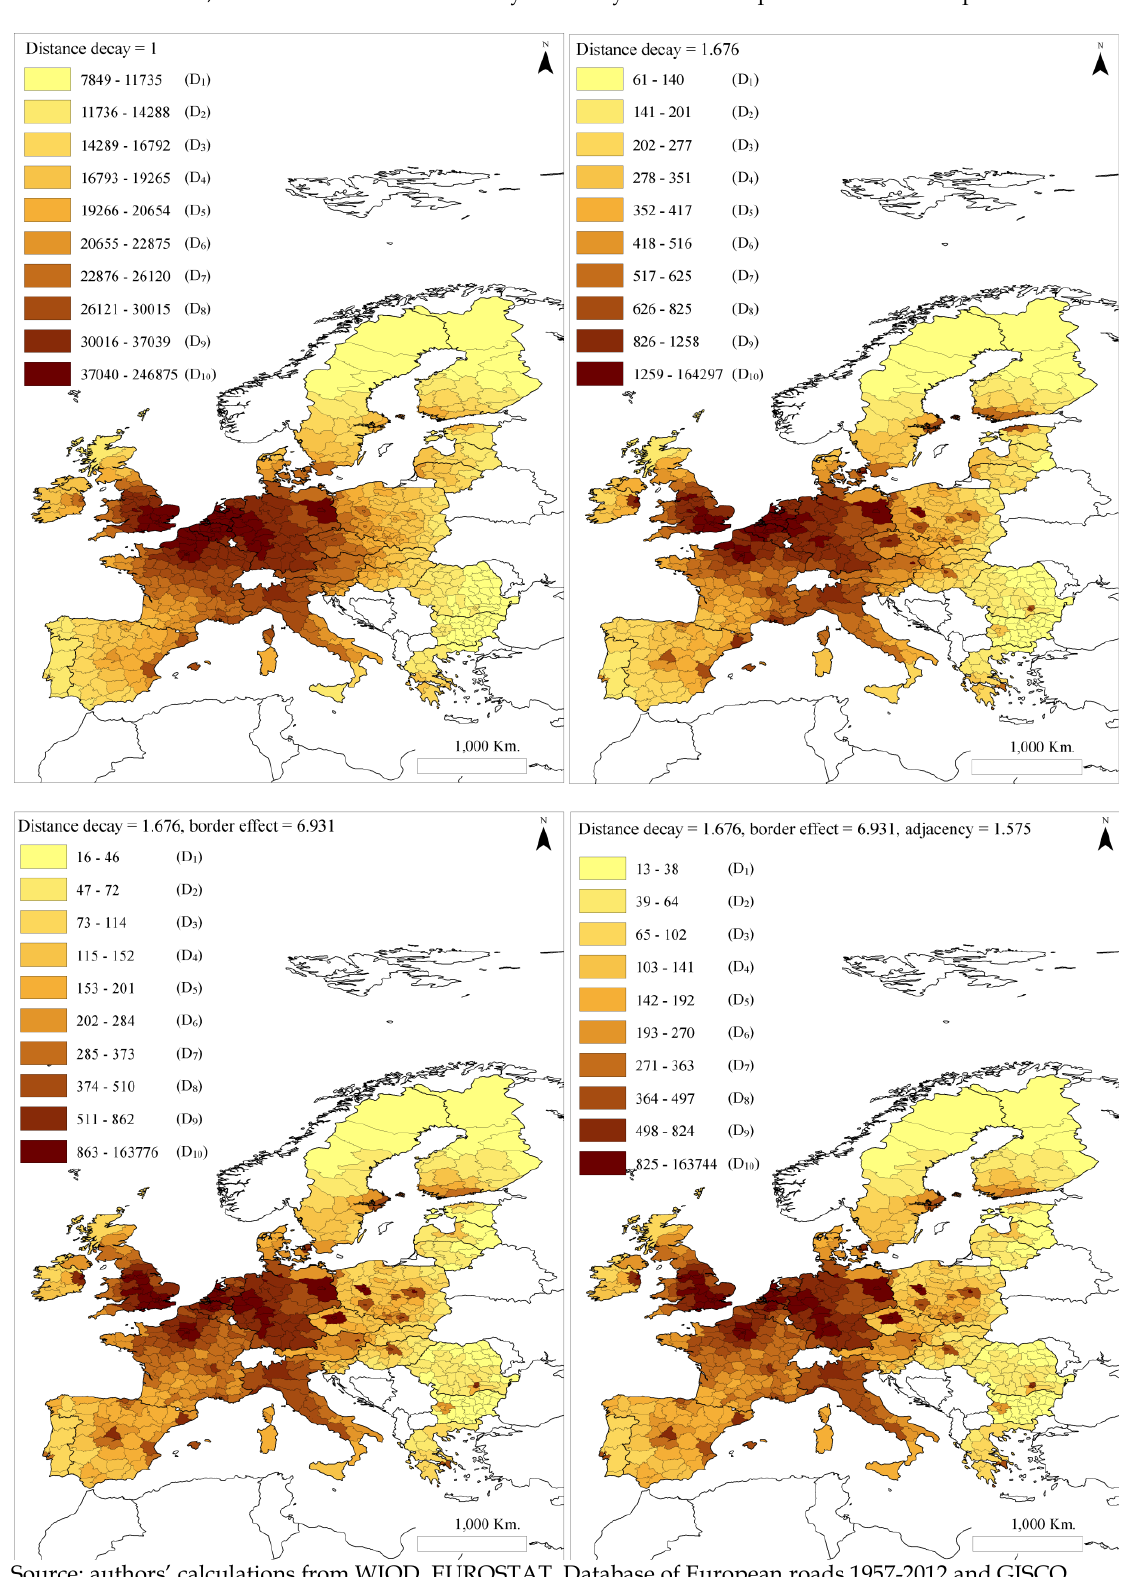
Figure 2. Market potential values according to different formulations: results per NUTS 2/3 level (in millions of market potential